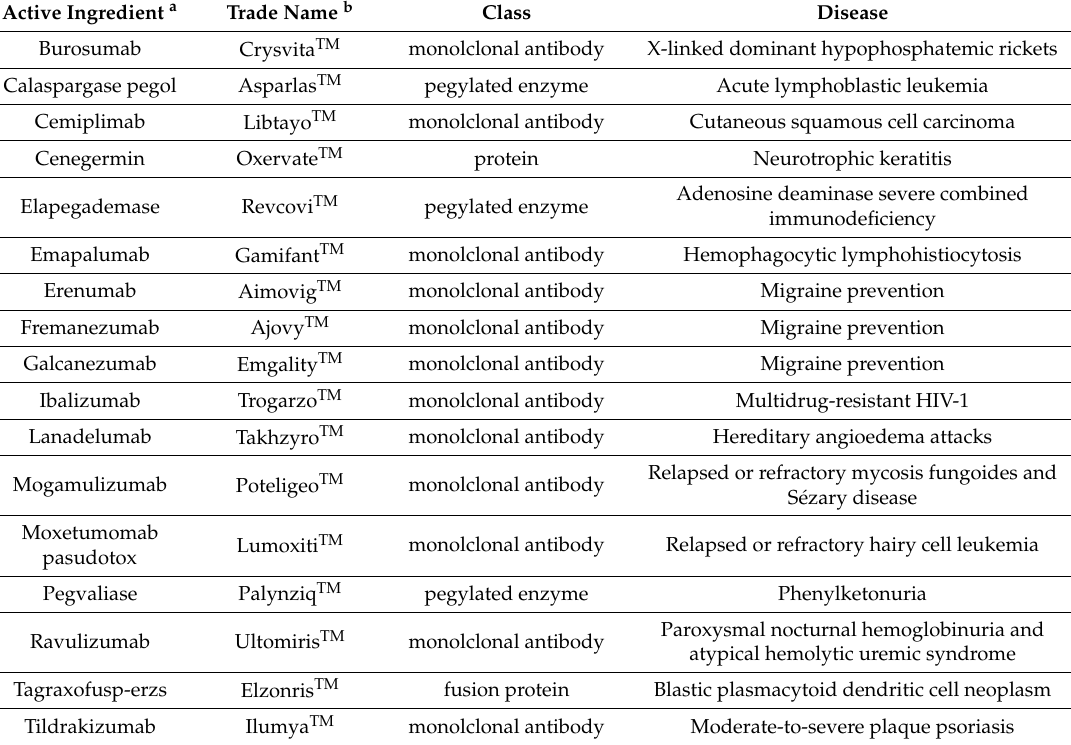
Table 1. Biologics approved by the FDA in 2018 [1].